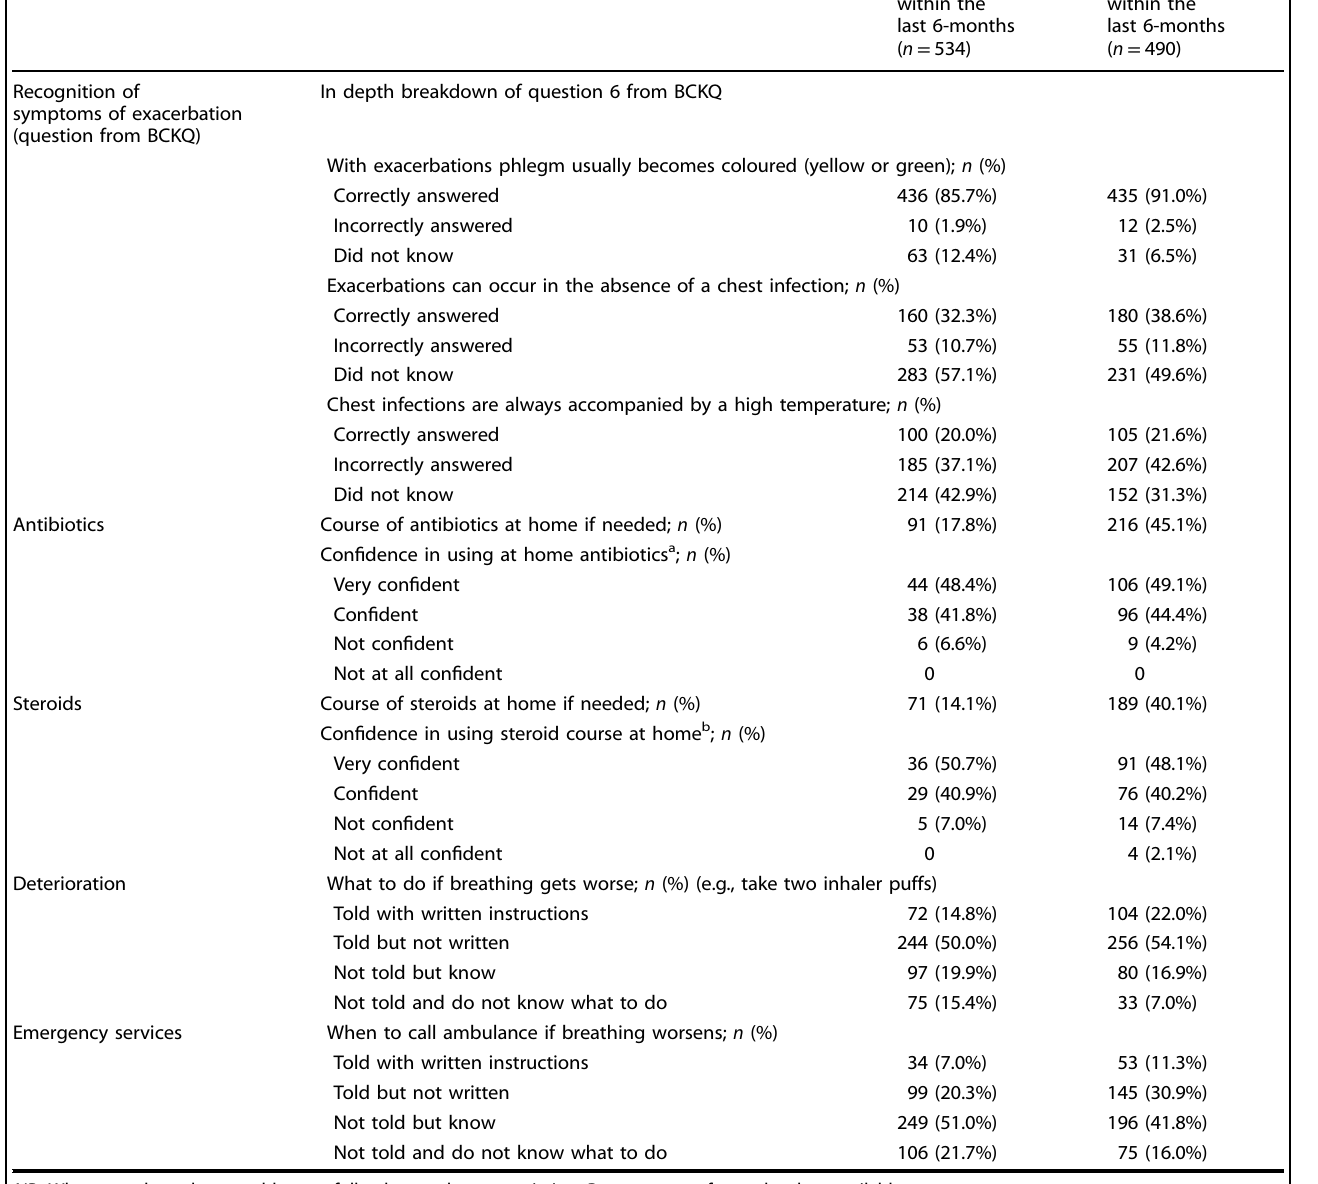
Table 4. Self-management behaviours: exacerbation-related symptom recognition and treatments at home